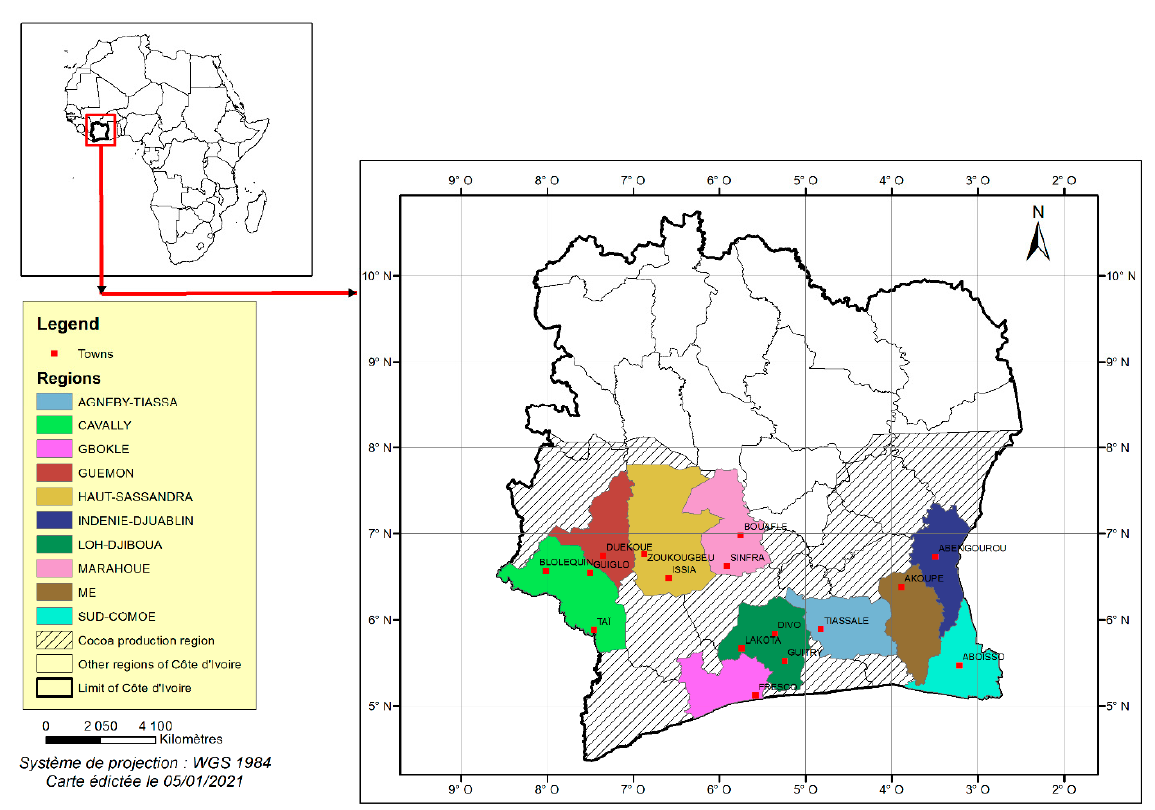
Figure 1. Sampling sites of a study aimed at identifying factors that drive tree species introduction into cocoa farms by farmers in Côte d’Ivoire.